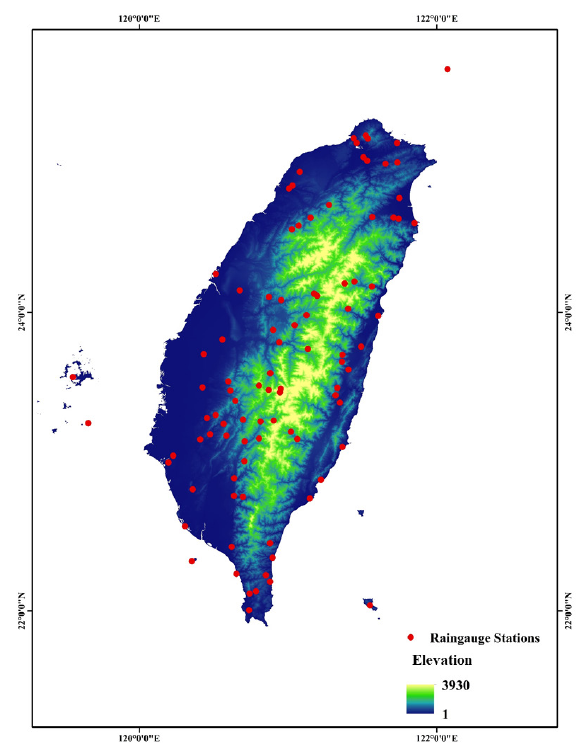
Figure1. Study area with Elevation and Rain gauge station